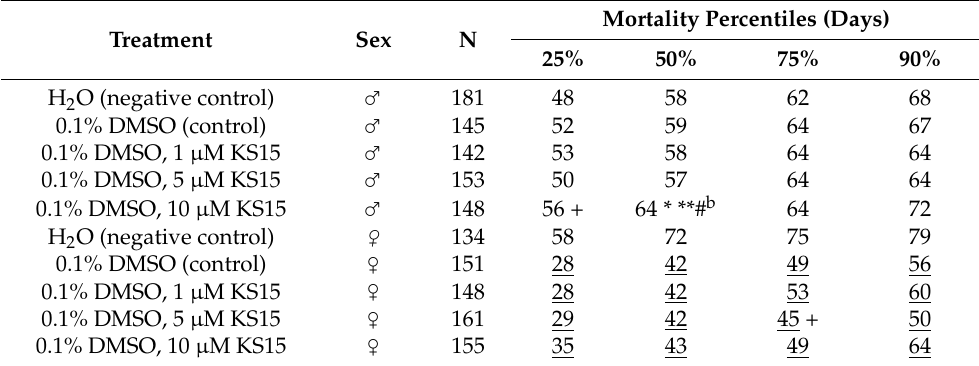
Table 3. The effects of KS15 on Drosophila melanogaster